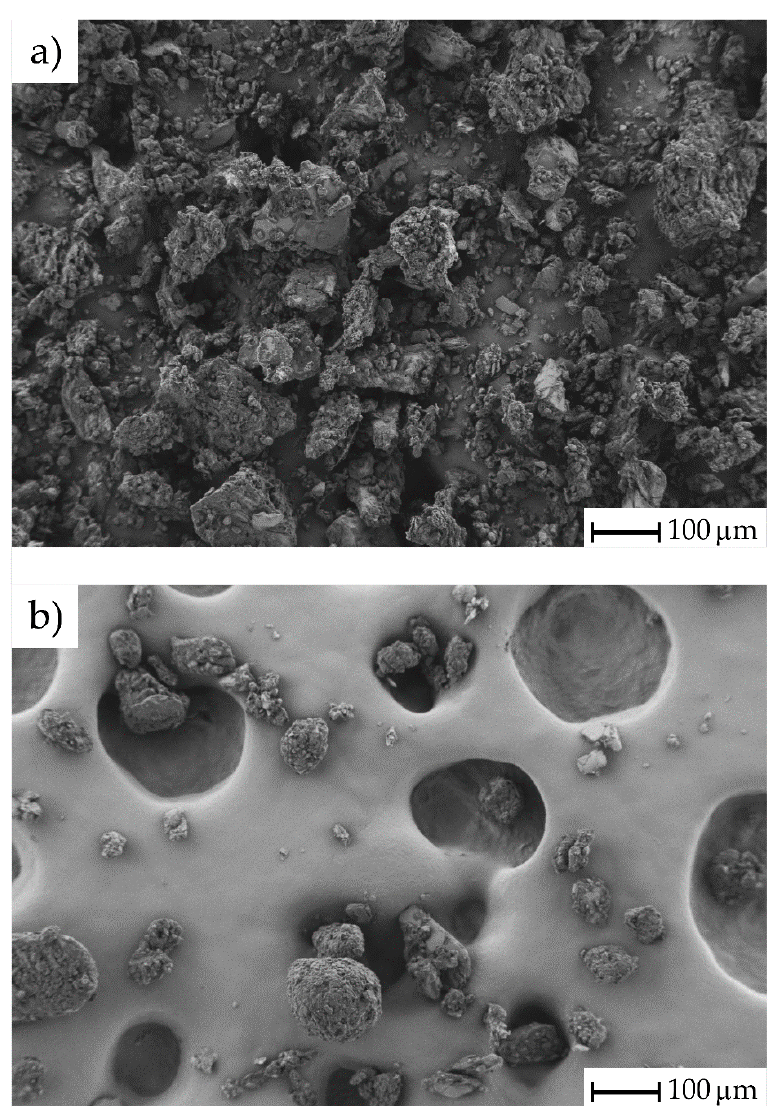
Figure 3. FESEM images corresponding to ( a ) CFF at 100× with a scale marker of 100 µm; ( b ) FFF at 100 × with a scale marker of 100 µ 100× with a scale marker of 100 µm.